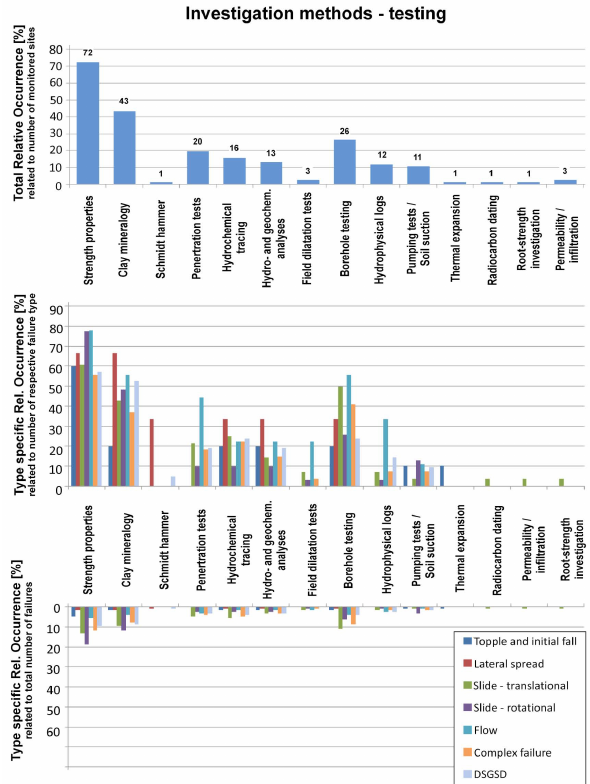
Fig. 6. Review of total relative occurrence and type-specific relative occurrence of testing approaches applied in the monitored landslide